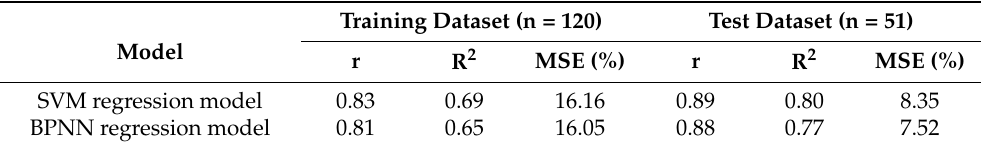
Figure 3. Relationships between the estimated and measured vegetation coverages in the training set ( a ) and test set ( b ) by the SVM regression model and in the training set ( c ) and test set ( d ) by the BPNN regression model. Table 7. Evaluation of vegetation coverage using the SVM and BPNN regression